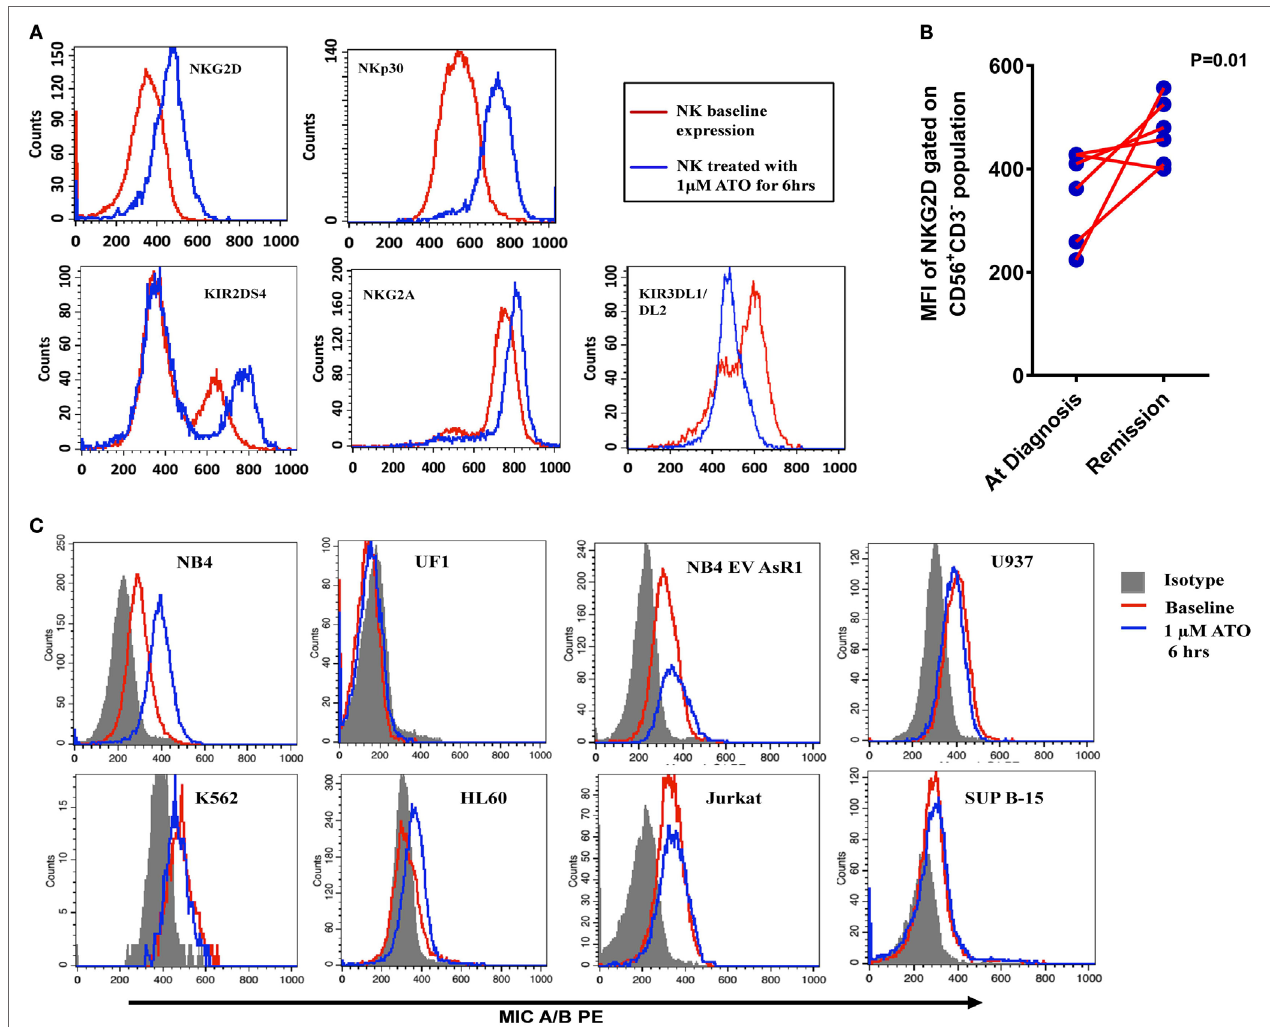
FigUre 4 | Alteration of NK receptor and ligand profile by arsenic trioxide (ATO). (a) Representative histogram plots of NK activating receptors NKG2D, NKp30, and KIR2DS4 and NK inhibitory receptor NKG2A of NK cell line (NK92MI) treated with 1 µM ATO for 6 h ( n = 5). The red lines represent the baseline expression and the blue lines which show a shift toward right indicated the increased expression with 1 µM ATO treatment for 6 h. (B) Mean fluorescence intensity (MFI) of NKG2D receptor expression (gated on CD56 + CD3 − population) in PBMNCs of acute promyelocytic leukemia (APL) patients at diagnosis and on remission ( n = 6). (c) Representative histogram plots of MICA/B expression in myeloid and lymphoid cell lines treated with 1 µM ATO for 6 h ( n = 3). The shaded region represents the isotypic controls and the red line represents the baseline expression of ligands. The blue lines which show a shift toward the right in NB4 indicating increased expression of MICA/B after ATO treatment which was not observed in other cell